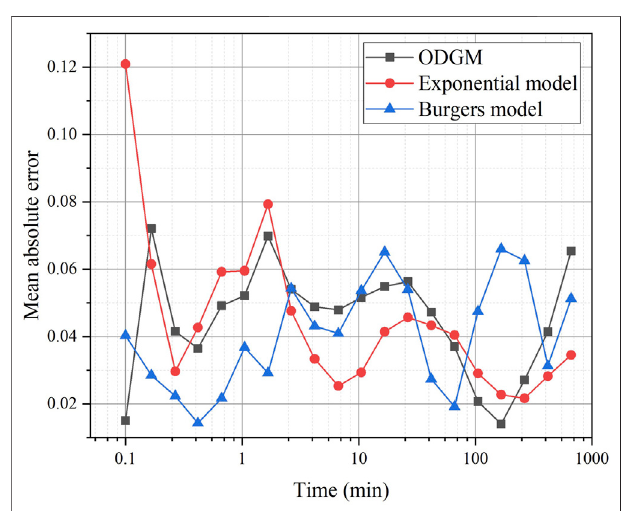
FIGURE 7 | Relationship of parameters of Burgers model and vertical stress.